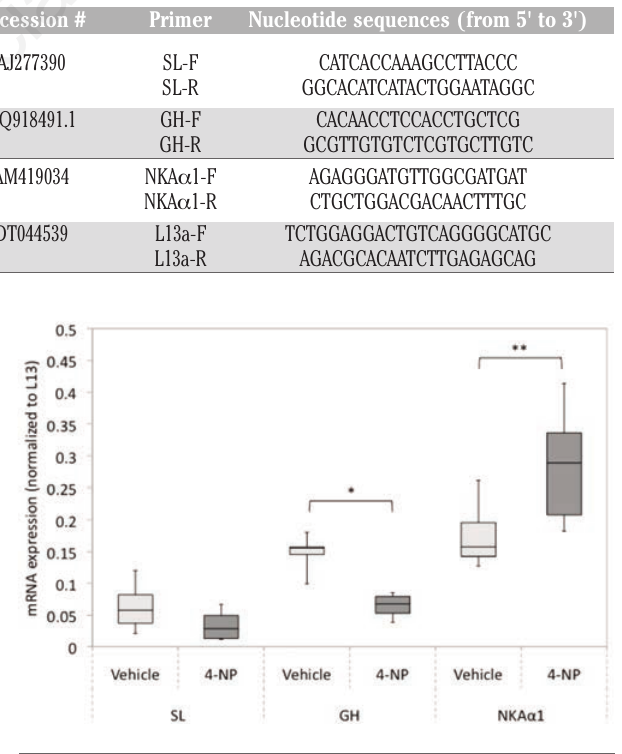
Figure 2. mRNA expression of somatolactin (SL) and growth hormone (GH) in the pituitary gland and Na + /K + ATPase alpha subunit (NKA α 1) in the gills of D. labrax exposed to 40±20 μ g/L of 4-NP or vehicle only (0.002% MetOH). Data are normalized to the ribosomal RNA L13a and expressed as mean±SD (n=5 for pituitary gland and n=10 for gills). *P<0.05; **P<0.01